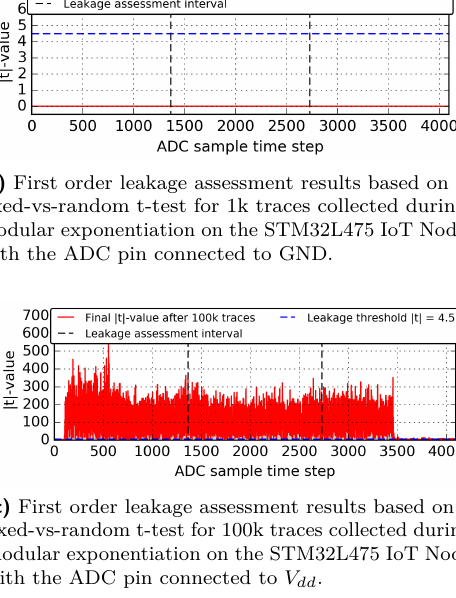
Figure 20: Results of Leakage Assessments on STM32L475 IoT Node for mbedTLS modular